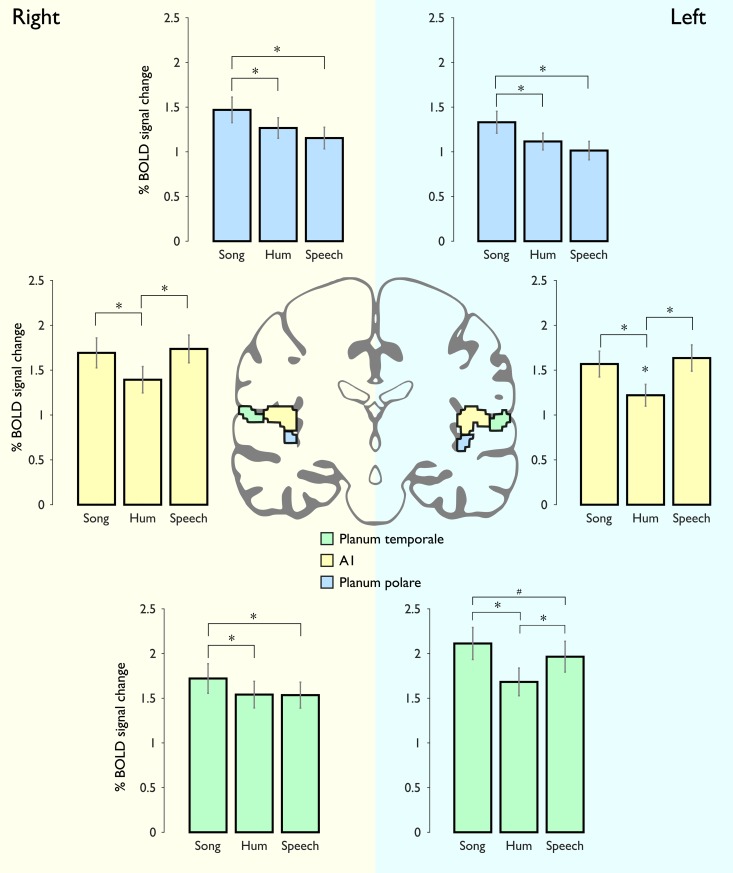
ROIs of Heschl's gyrus, planum polare and planum temporale.Right and left hemispheres are shaded in different colors. Top panel: The percentage of BOLD signal modulation in the planum polare (blue color) showed similar patterns between the right and left hemisphere, the highest level of activation in this region corresponded to Song, followed by Hum and Speech sounds; statistical differences were found between Song and Speech. Middle panel: BOLD signal changes in the right and left Heschl's gyrus (yellow color), no differences between Song and Speech stimuli. Bottom panel: The left and right planum temporale (green color) exhibited different patterns of activation, in the right hemisphere Song stimuli elicited the highest values, while in the left hemisphere there were no differences between them. * indicates significant difference from the rest of the stimuli (p<0.0028; Bonferroni correction); # stands for uncorrected p<0.05.